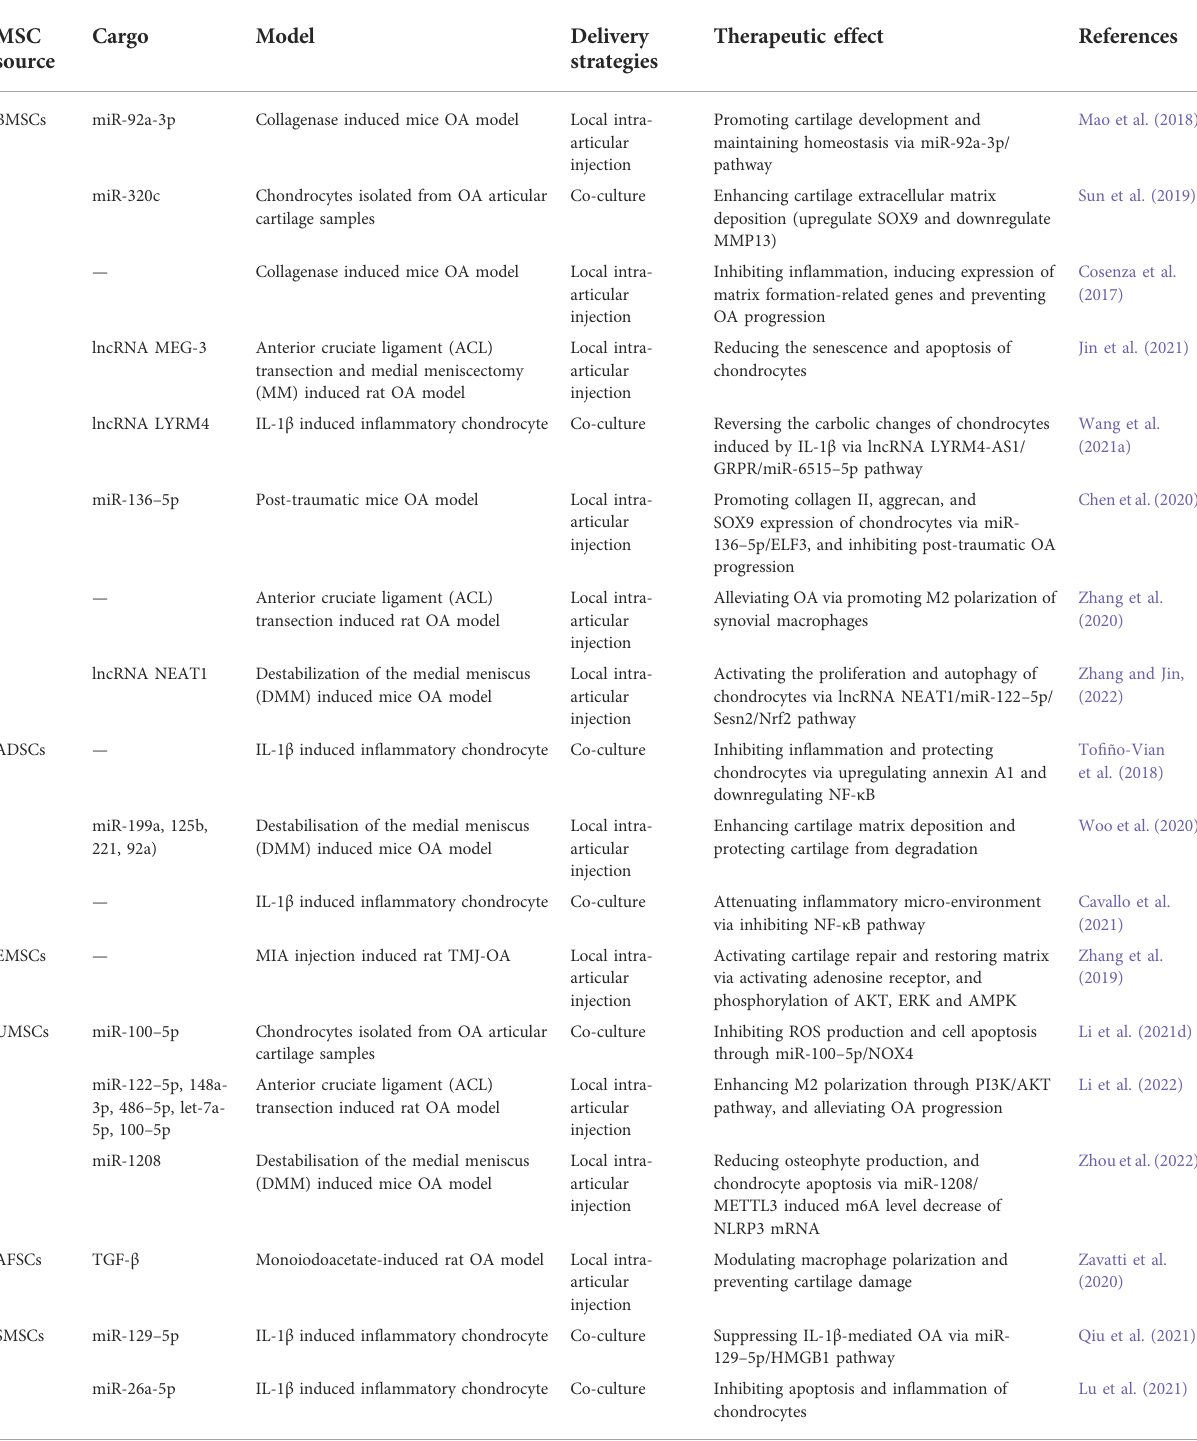
TABLE 1 The therapeutic role of different MSC-EVs in OA